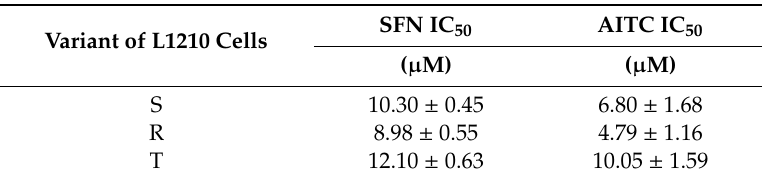
Table 1. Values of IC 50 for SFN or AITC obtained by nonlinear regression of data for S, R and T cell proliferation according to